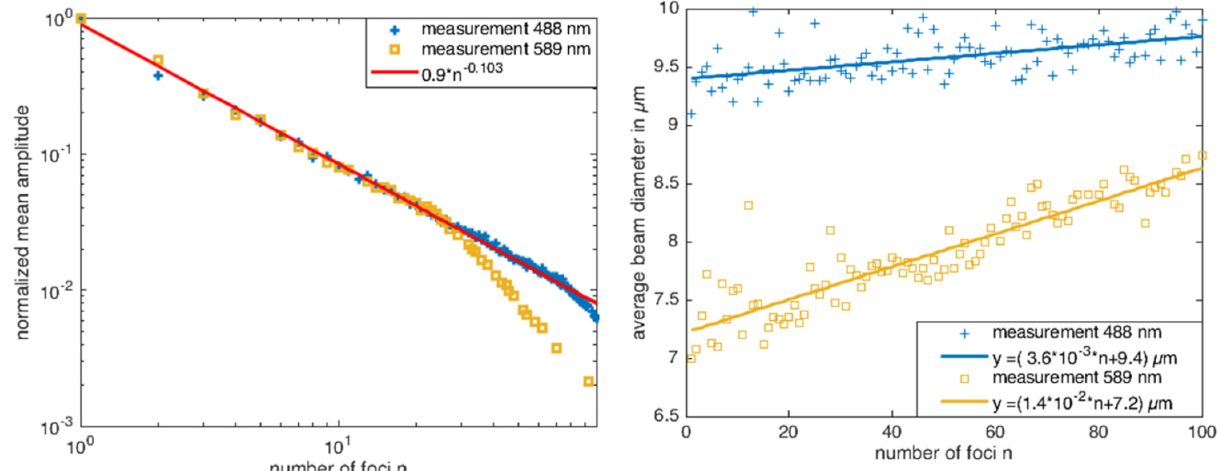
Figure 4. Left : Distribution of average focus intensity normalized to camera acquisition time over number of generated foci as a log–log plot. Data are further normalized to the maximum at n = 1. A wavelength-dependent drop in SNR is visible for both colors starting at around n = 20 for 589 nm and n = 60 for 488 nm, which might be attributed to the differences in spatial frequencies necessary for displaying foci in a fixed field of view. Right : Increase of the mean focus diameter over the number of foci.